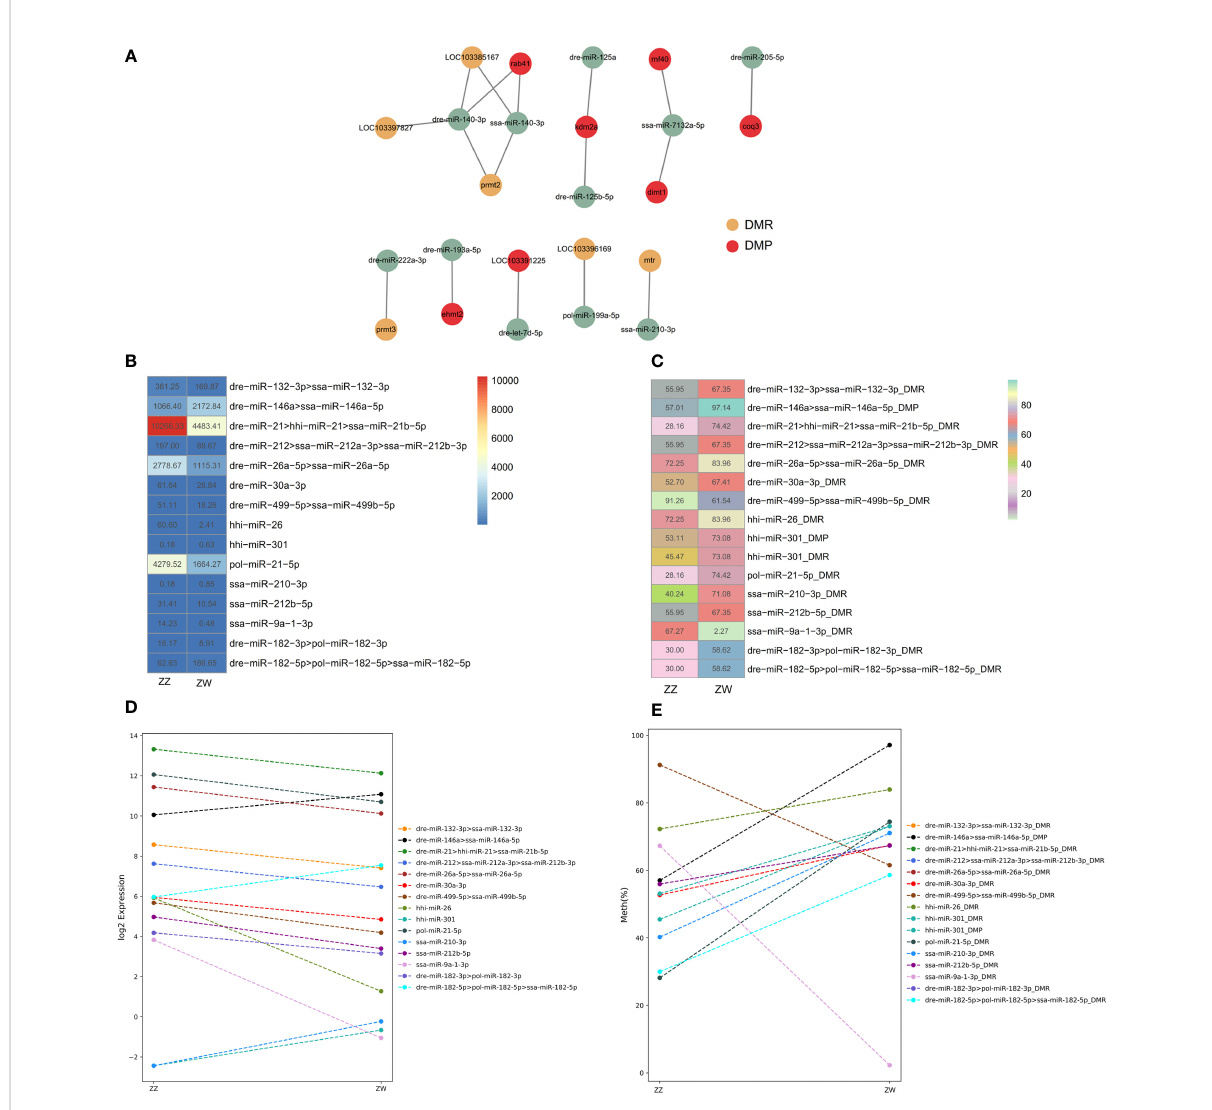
FIGURE 7 Interaction patterns of DMR/DMP and DEMs (A) Cytoscape of DEMs and their corresponding methyltransferases and demethylase related target DMR/DMP. Yellow represents DMR, red represents DMP, Green represents DEMs. (B) Heatmap of expression level of 15 DEMs between ZW and ZZ sperm groups. (C) Heatmap of the methylation level on promoters of a total 15 DEMs. (D) Dot line diagram illustrated trend of up-regulated and downregulated of 15 DEMs between ZW and ZZ groups. (E) Dot line diagram illustrated trend of hyper-methylated and hoper – methylated trend of DMR/DMPs of 15 DEMs between ZW and ZZ